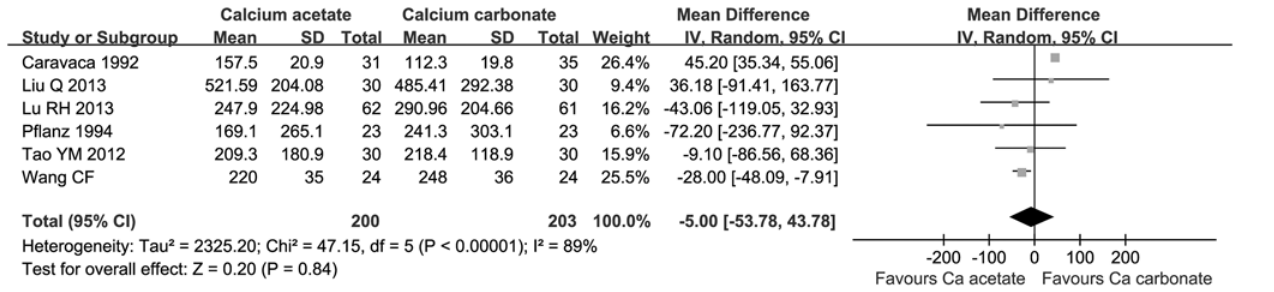
Fig 5. Serum PTH levels after 8 weeks administration of calcium-based phosphate binders.